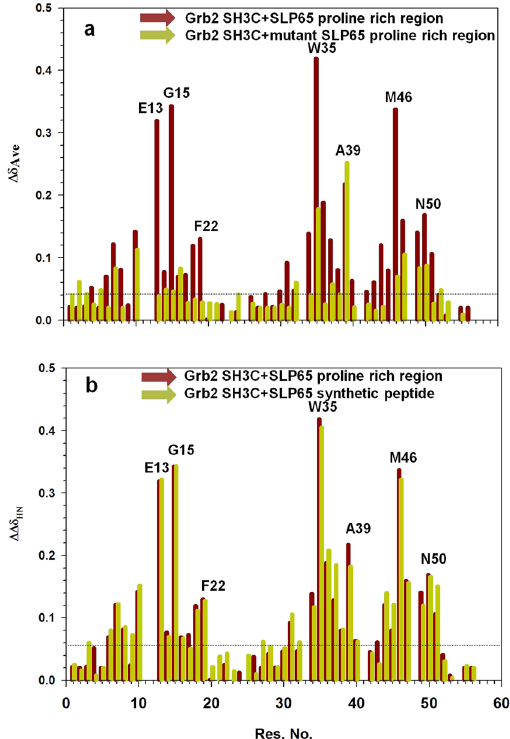
Figure 1. Backbone amide chemical shift perturbations of the Grb2 SH3C domain upon binding SLP65. Comparison of the average chemical shift changes of the Grb2 SH3C amides upon addition of ( a ) wild type SLP65 proline rich region (residues 125–330, brown) and P212A mutant of the proline rich region (green). ( b ) the wild type proline rich region of SLP65 (brown) and a synthetic peptide Ace-EKAPMVNRSTKPNSSS-NH2